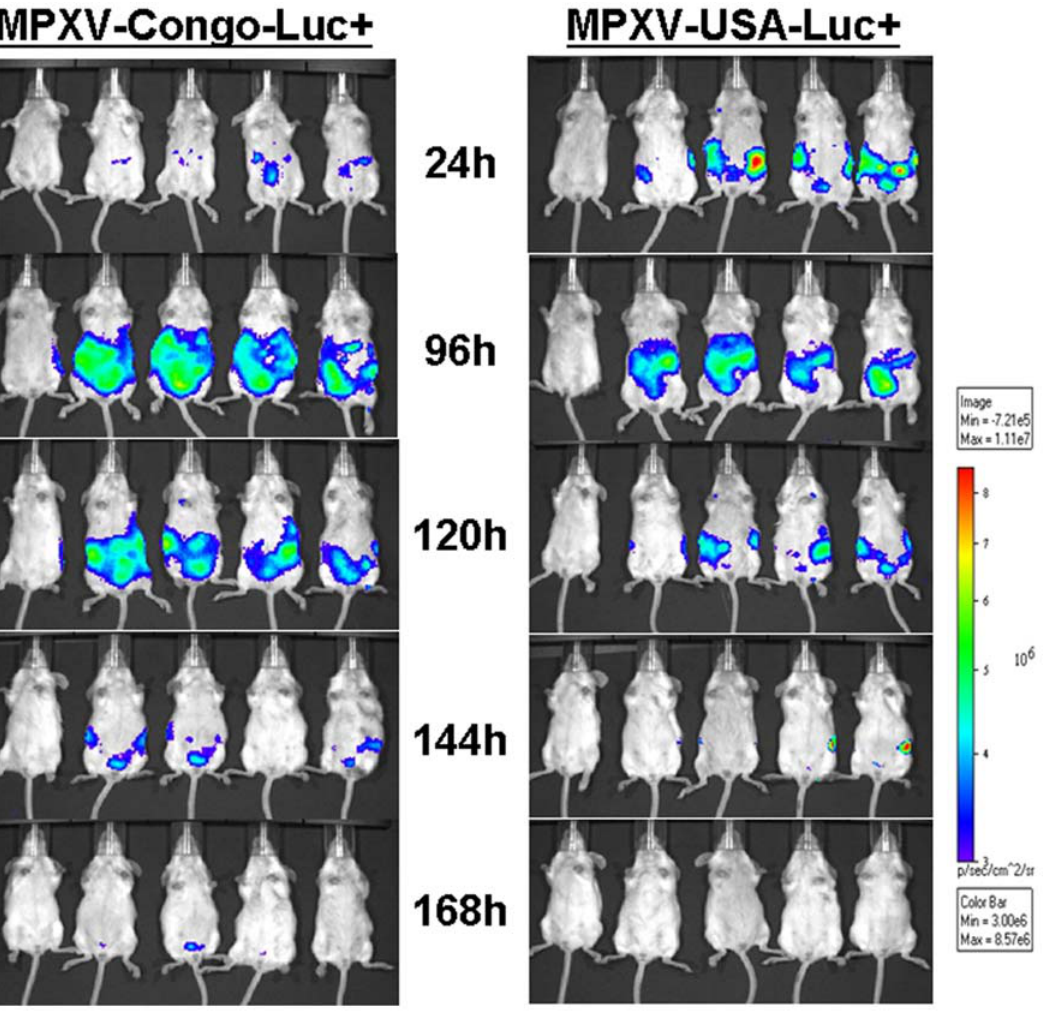
Figure 2. In vivo imaging of MPXV-Congo-Luc + (left panel) and MPXV-USA-Luc + (right panel) in BALB/c mice (Intraperitoneal inoculation). Groups of four, 4-week-old BALB/c mice were inoculated by the IP route with 105 PFU of either MPXV-Congo-Luc + or MPXV-USA- Luc + viruses. At indicated times post-infection, mice were injected IP with 1.5 mg luciferin in 100 m l of DPBS (Promega, Madison, WI) and imaged (ventral view) in an IVIS 200 imager (Caliper Life Sciences, Alameda, CA). Exposures for 30 sec (F8, medium binning) were taken at approximately 12 minutes post-luciferin injection following anaesthetization with isoflurane. An uninfected negative control animal (first animal on left side) was also injected with luciferin and imaged on the same times as infected animals. Images were analyzed with Living Image 3.0 software (Caliper Life